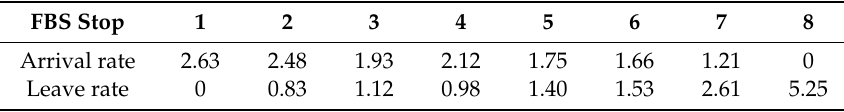
Table 2. Average arrival and leave rate at each stop (unit: people/min).